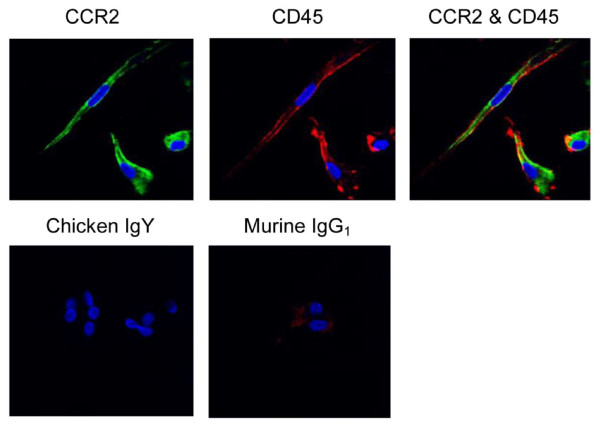
Positive chemokine (C-C motif) receptor 2 (CCR2) expression in human blood fibrocytes by confocal microscopy. Fibrocytes after primary passage were costained with CCR2 and CD45 or isotype controls (chicken IgY and murine IgG1). Nuclei were stained with 4',6-diamidino-2-phenylindole (DAPI; blue). Cells were examined at 60 × magnification. Representative images from three donors.